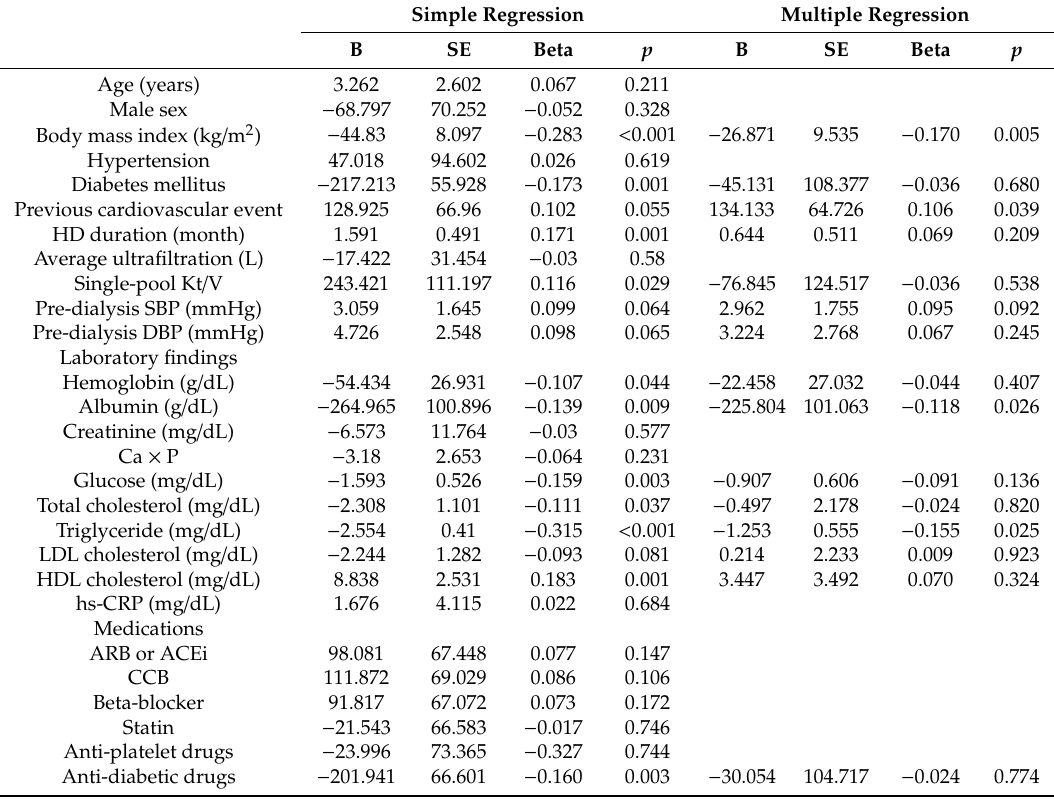
Table 2. Association between plasma endocan level and various clinical